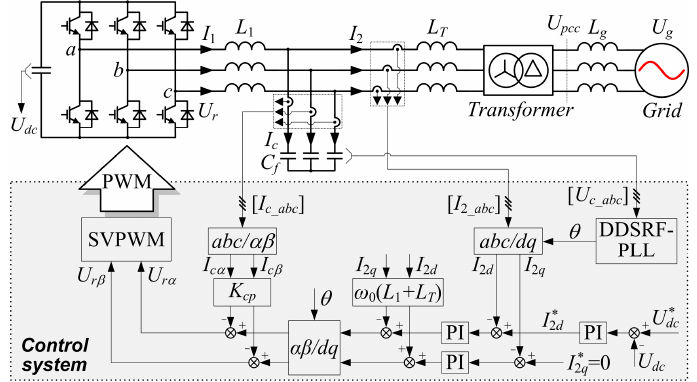
Figure 2. Topology and control block of three-phase LCL-type grid-connected converter.